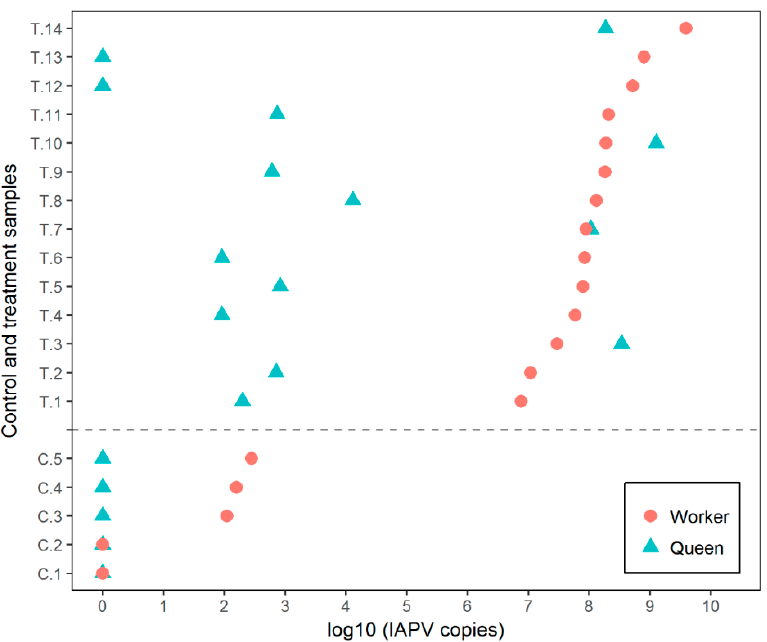
Figure 1. Israeli acute paralysis virus (IAPV) titers of worker and queen samples in control and treatment groups. IAPV-inoculated workers developed virus titers in the range of 7.62 × 10 6 to 3.91 × 10 9 copies/ µ L. Queens in trophallactic and direct physical contact with infected workers became also infected (IAPV titers ranged from 9 × 10 1 to 1.25 × 10 9 copies/ µ L). Two queens with infected workers showed no detectable virus. Queens in the control cages remained uninfected, even though accompanying workers in three experimental cages showed a low level of IAPV (1.09 × 10 2 to 2.78 × 10 2 copies/ µ L). Thus, IAPV titers were lower in queens than in the corresponding workers in 14 cases, while the opposite was true in only 3 cases. T = IAPV-infected workers, C = control workers.